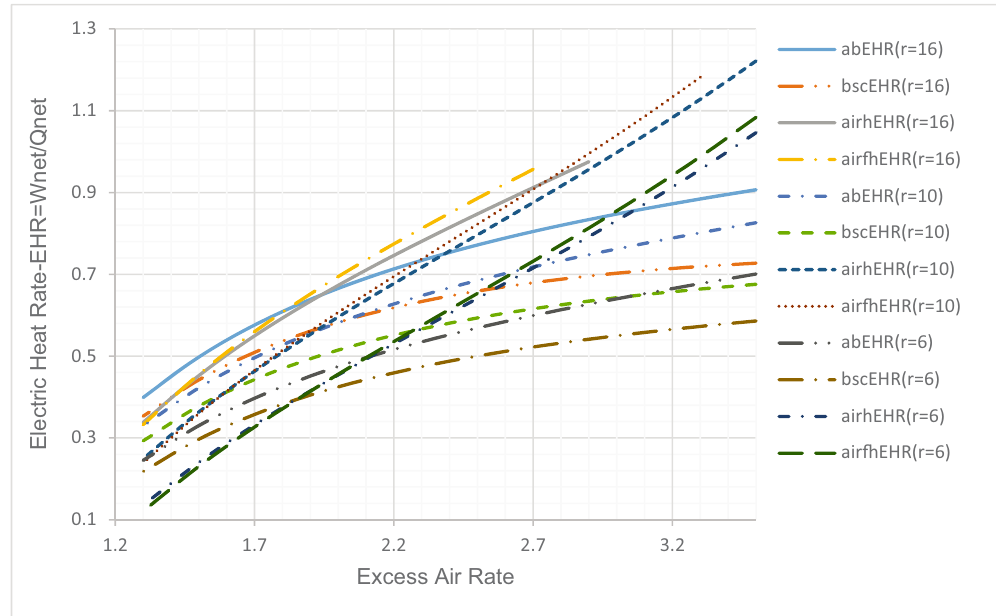
0.10.30.50.70.91.11.3 Figure 5: Variation of the electrical heat energy ratio with air excess coe ffi cient at di ff erent compressor compression ratios for basic ( bsc ) , absorption cooling ( ab ) , air ( airh ) , and air fuel ( airfh ) heating cogeneration cycles ( m fuel = 1.64 kg/s, η isC = η isT = 0.86, T recout = 850 K, T = 426 K ) steam